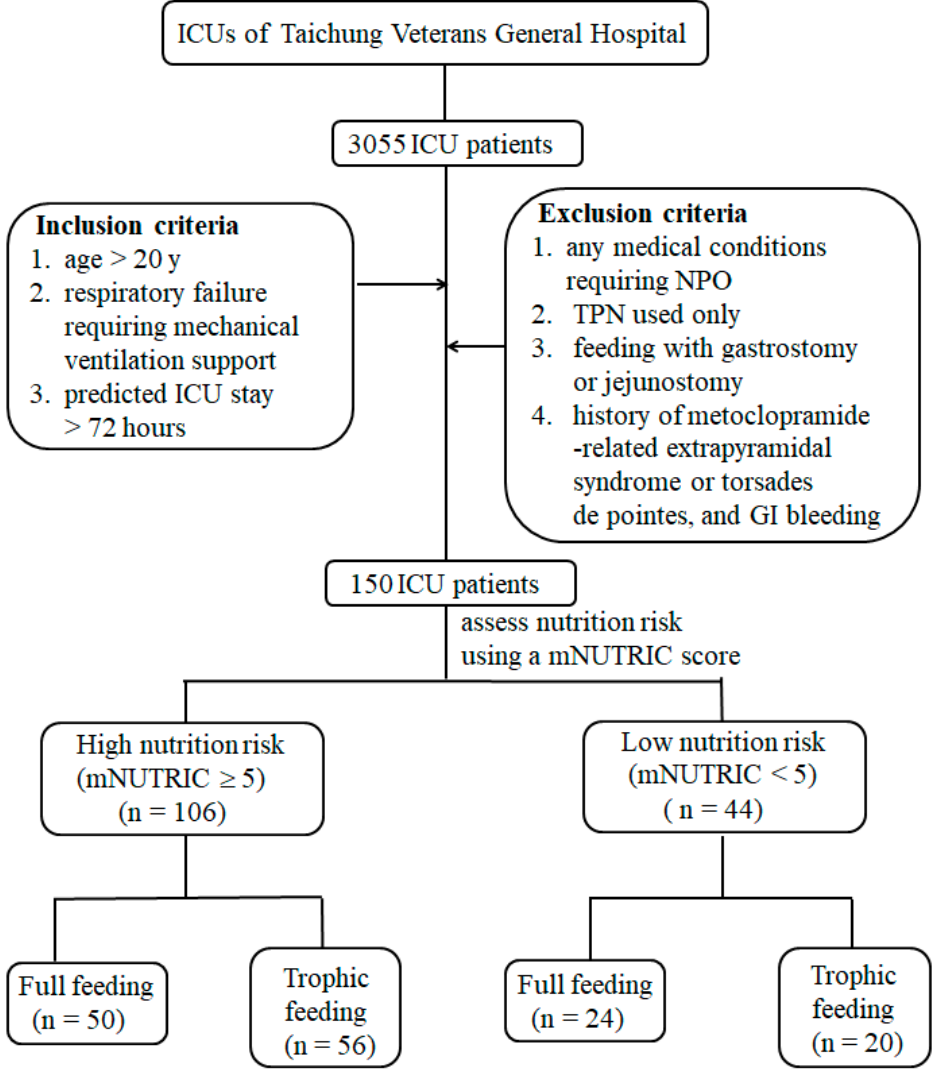
Figure 1. Patient recruitment and flow of the